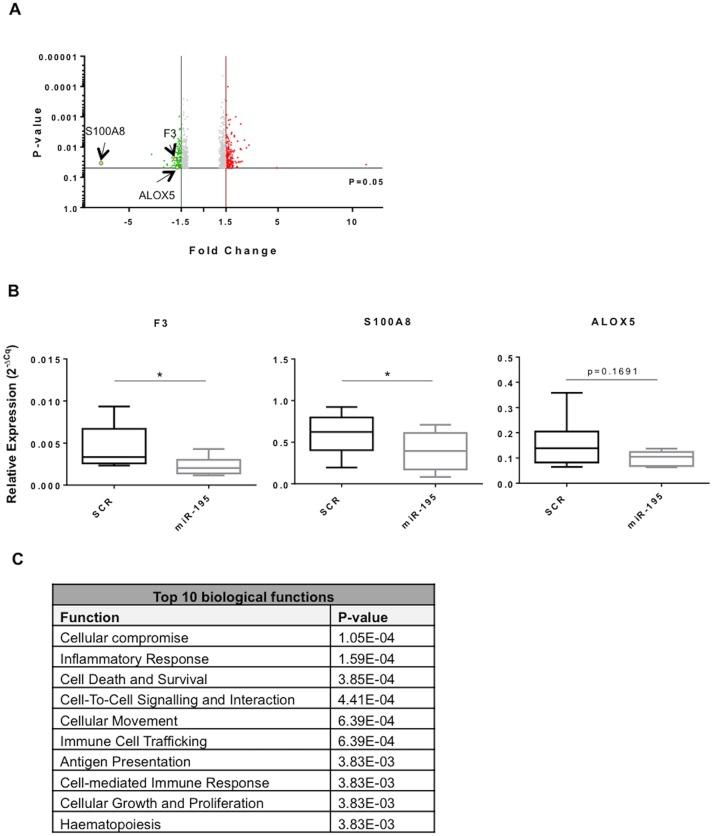
miR-195 downregulated genes are associated with inflammatory and cell recruitment mechanisms.A) Volcano plot of statistical significance against fold change representing most deregulated genes between miR-195 and SCR-transfected THP-1 macrophages. Green dots represent downregulated genes (fold change <-1.5); red dots represent upregulated genes (fold change > 1.5). F3, S100A8 and ALOX5 involved in atherosclerosis signaling appear highlighted. B) Measurement of F3, S100A8 and ALOX5 expression levels by RT-qPCR (n = 4). C) List of the 10 most prominent biological functions of genes downregulated by miR-195, determined by IPA. Statistical significance: *p<0.05.